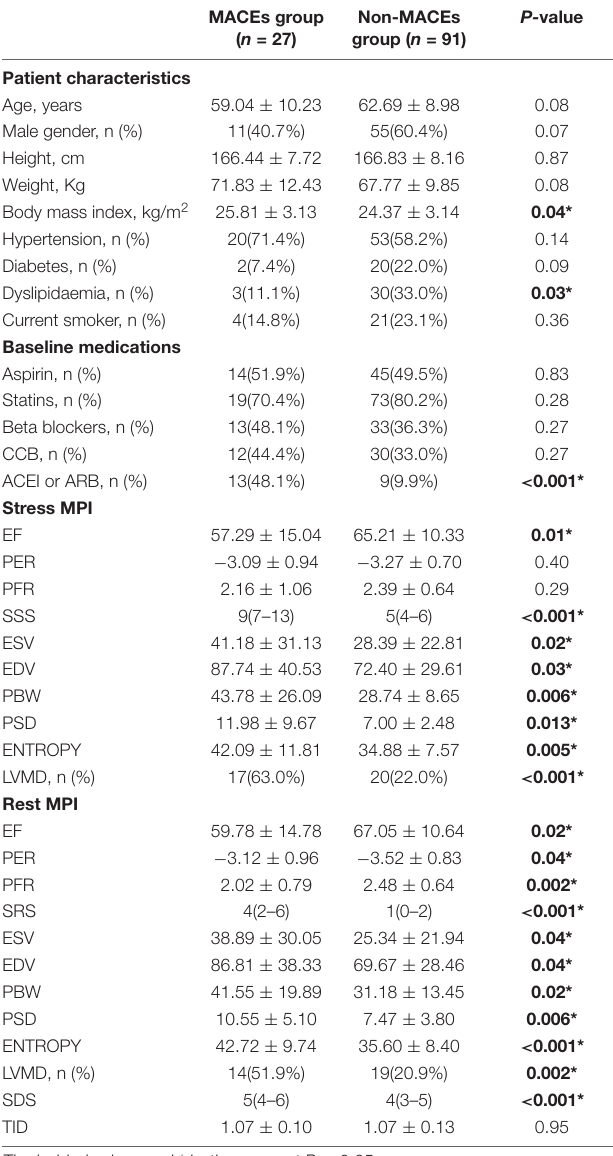
TABLE 4 | Comparison of risk factors between MACEs and non-MACEs groups. MACEs group Non-MACEs P- value ( n = 27) group ( n = 91) analysis are reported in Table 5 . Stress EF (HR: 0.974, 95%